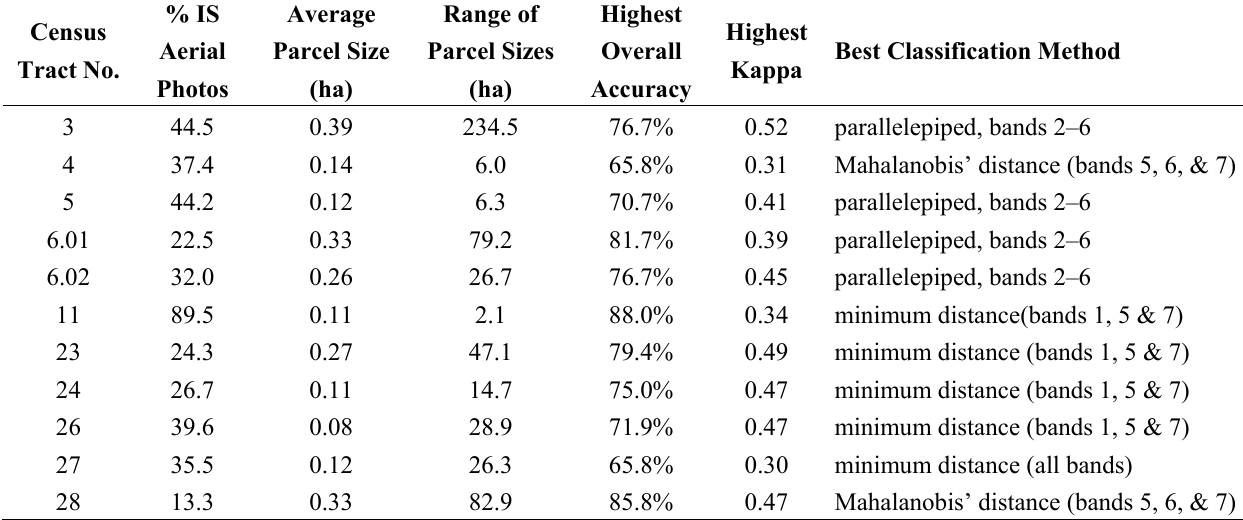
Table 8. Summary of census tract characteristics and best classification method for that census